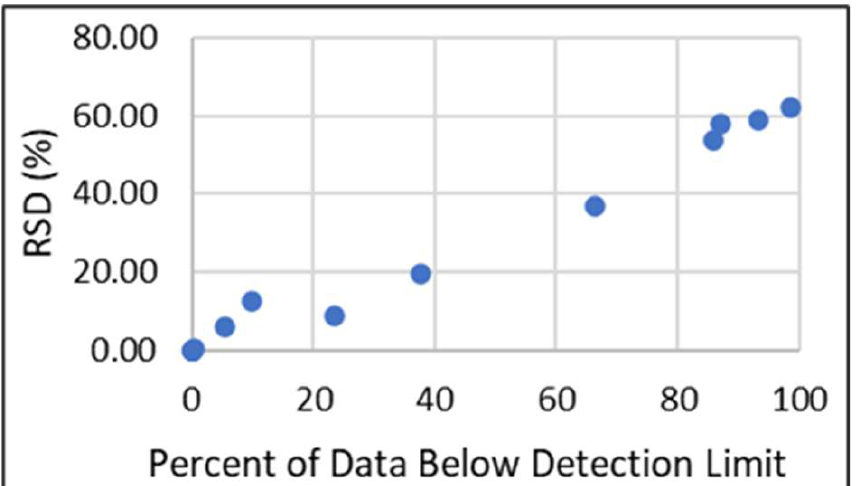
Figure 3. RSD vs. percent of BDL data.